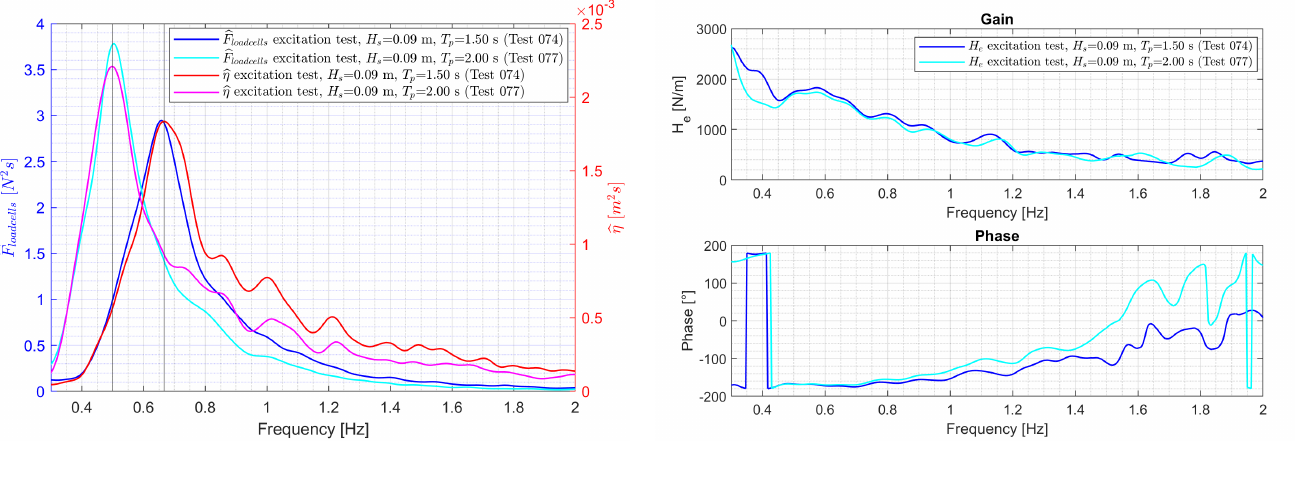
Figure 13. Wave excitation Test_074 and Test_077: ( a ) (cid:98) F loadcells and (cid:98) η , frequency smoothened over a window of 30 frequencies; ( b ) H e , frequency smoothened over a window of 30